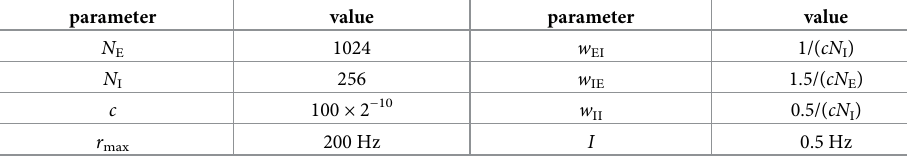
Table 1. Rate network parameters (unless specified